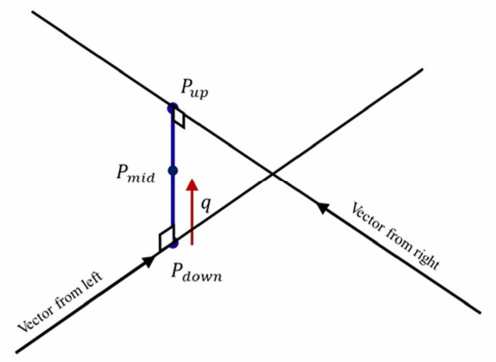
Figure 7. Two vectors in a skew